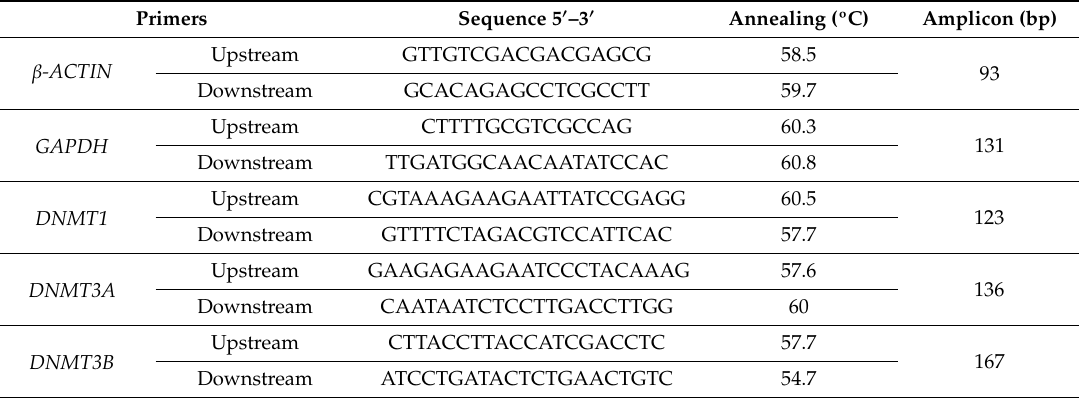
Table 1. Primer pairs to assess gene transcript expression in DPSCs by